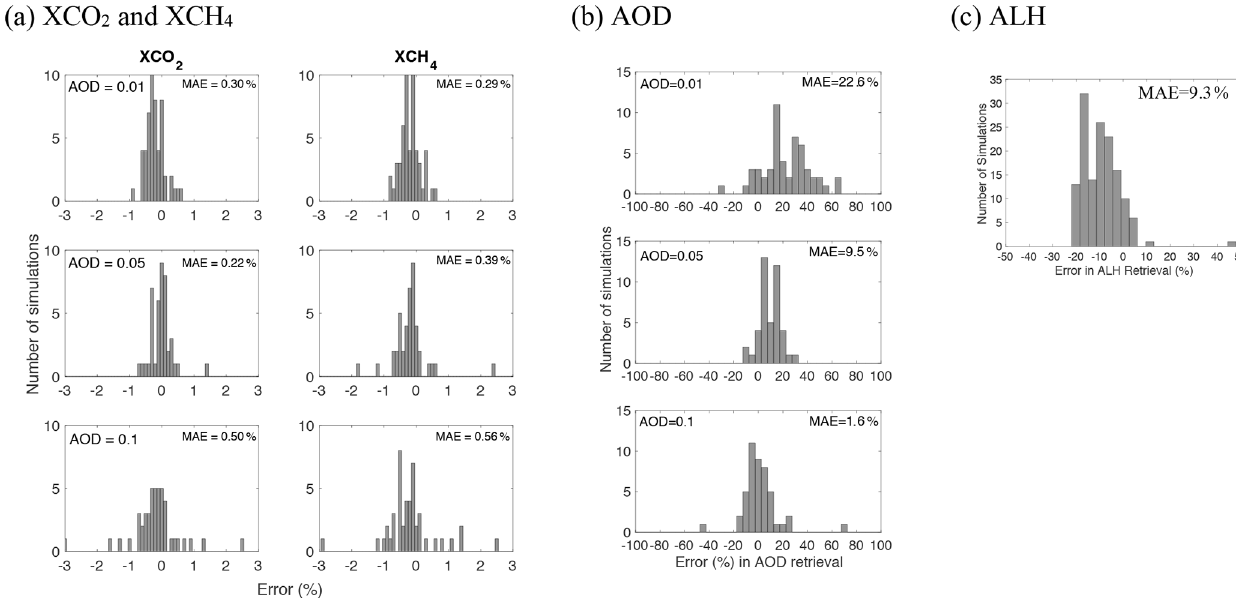
Figure 11. Results for Test 2. Errors in retrieved (a) XCO 2 and XCH 4 for three different values of AOD (0.01, 0.05, and 0.1), (b) AOD for the same scenarios as in (a) , and (c) ALH for all AOD scenarios. The errors have contributions from biases due to the O-PCA RTM and due to the imperfect knowledge of aerosol optical properties and vertical distribution of atmospheric trace